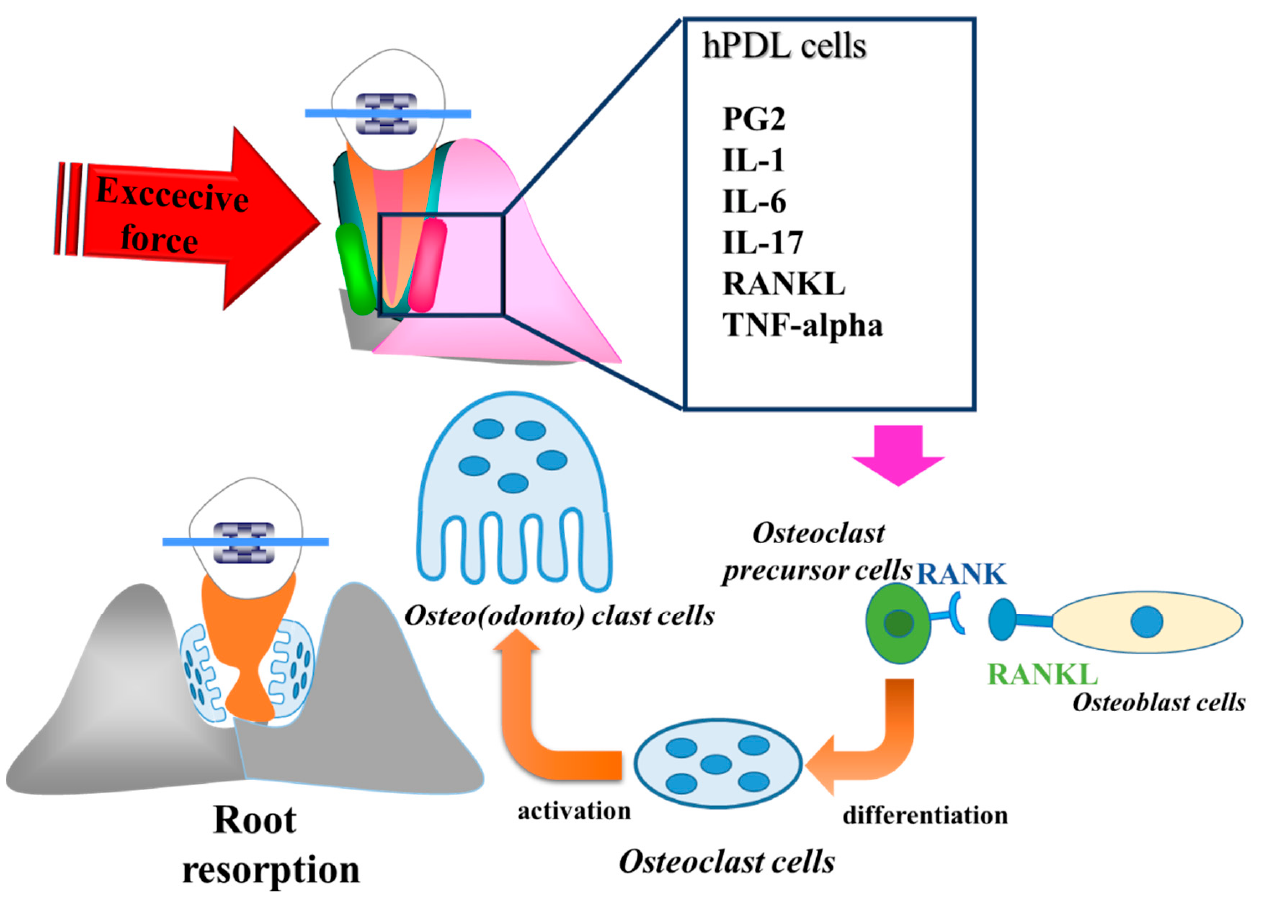
Figure 6. The schema of mechanism of OIIRR. Abbreviations; OIIRR = orthodontically induced inflammatory root resorption, hPDL cells = Human periodontal ligament cells, PGE2 = prostaglandin E2, IL-1 = interleukin 1, IL-6 = interleukin 6, IL-17 = interleukin 17, RANKL = Receptor activator of nuclear factor ligand, RANK = Receptor activator of nuclear factor, TNF-alpha = tumor necrosis